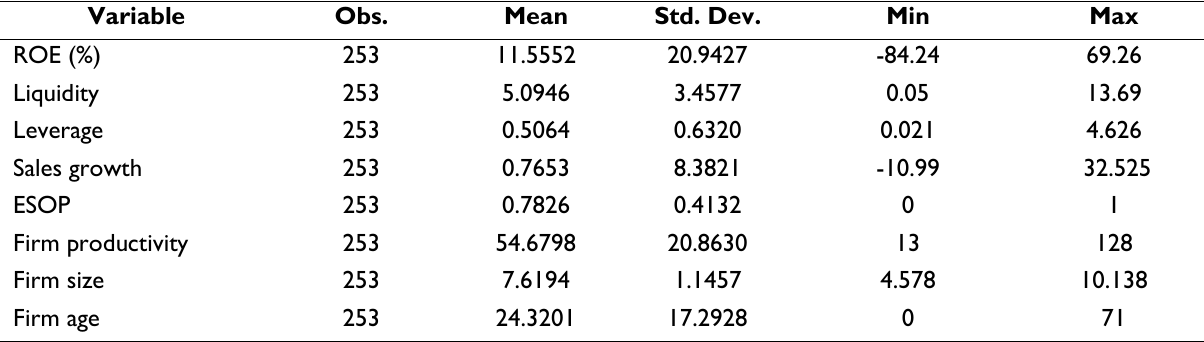
Table 5: Breusch-Pagan / Cook-Weisberg test for Heteroskedasticity Dependent